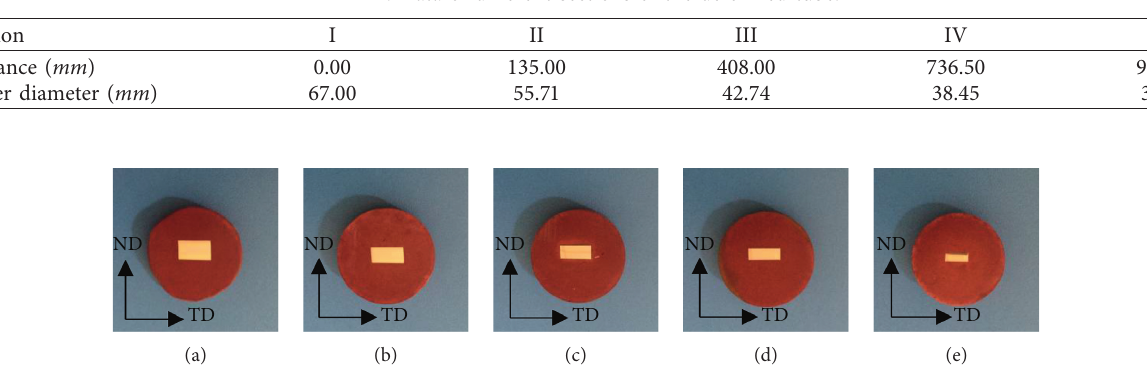
Figure 2: The mosaic specimen of each deformation section perpendicular to the direction of the pipe, that is, the plane composed of ND and TD (observation surface A). (a) Deformation I. (b) Deformation II. (c) Deformation III. (d) Deformation IV. (e) Deformation